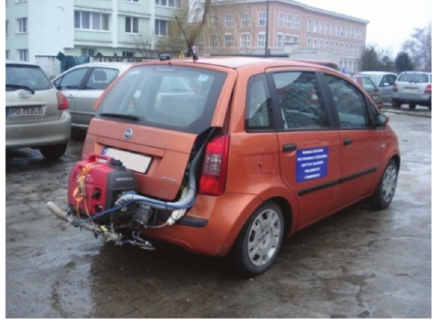
Fig. 1. Fiat Idea with mounted exhaust measuring apparatus